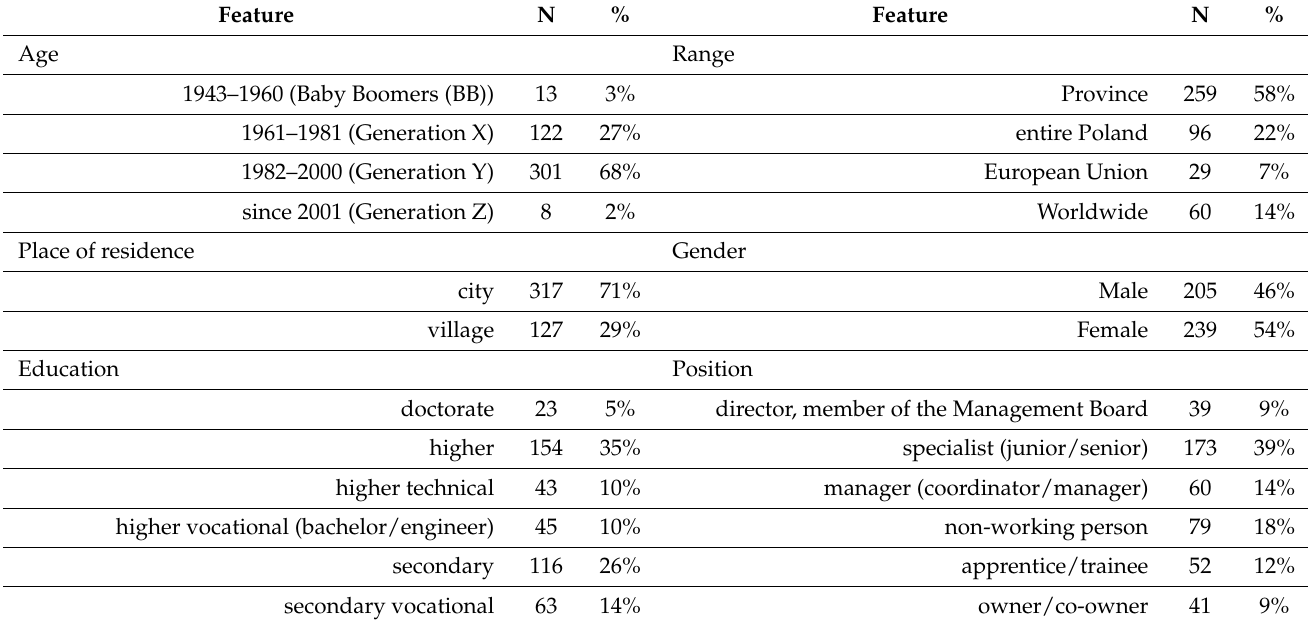
Table 1. Characteristics of the surveyed group of